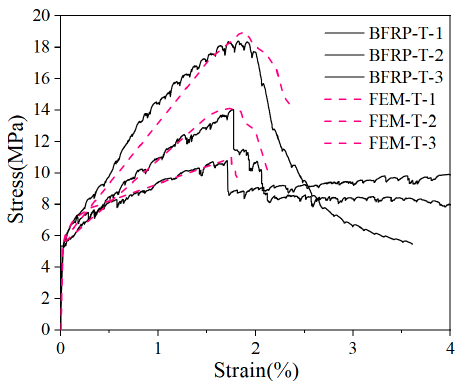
Figure 14. Stress–strain curves of the experimental results and numerical simulation results.